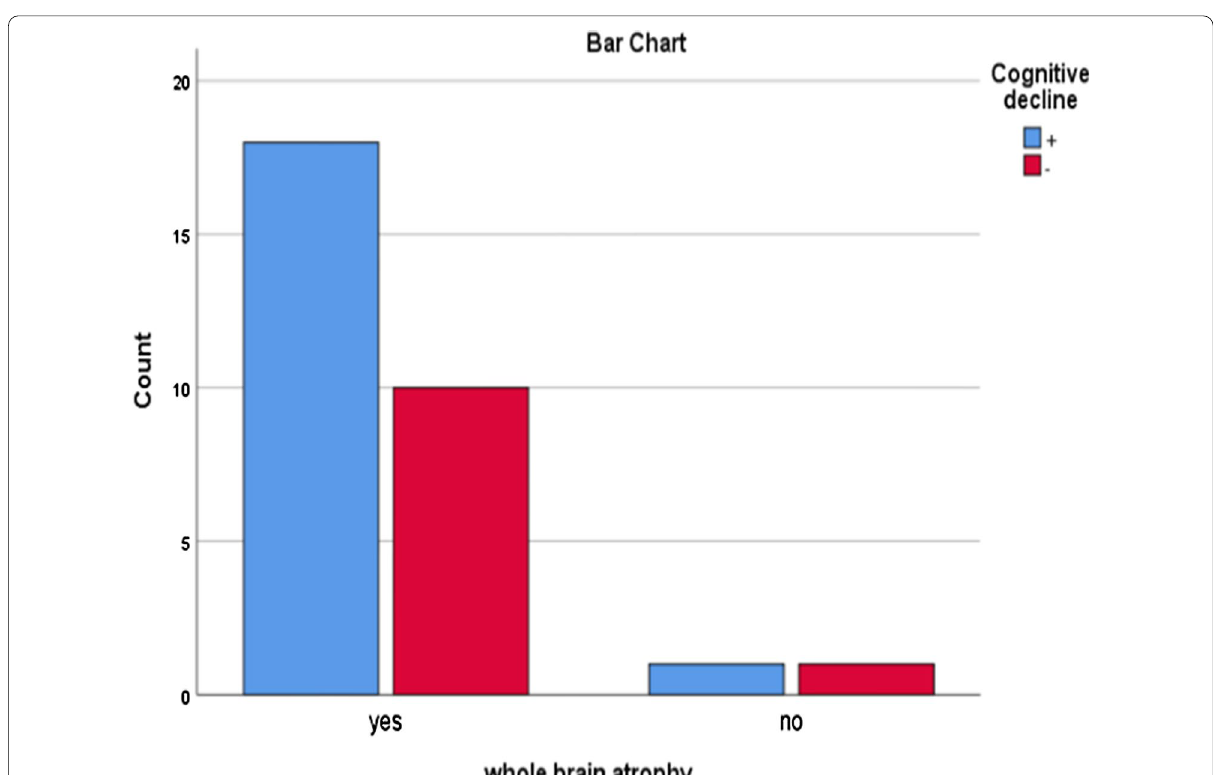
Fig. 16 Diagrammatic representation of number of patients with cognitive decline in patients with and without whole brain atrophy